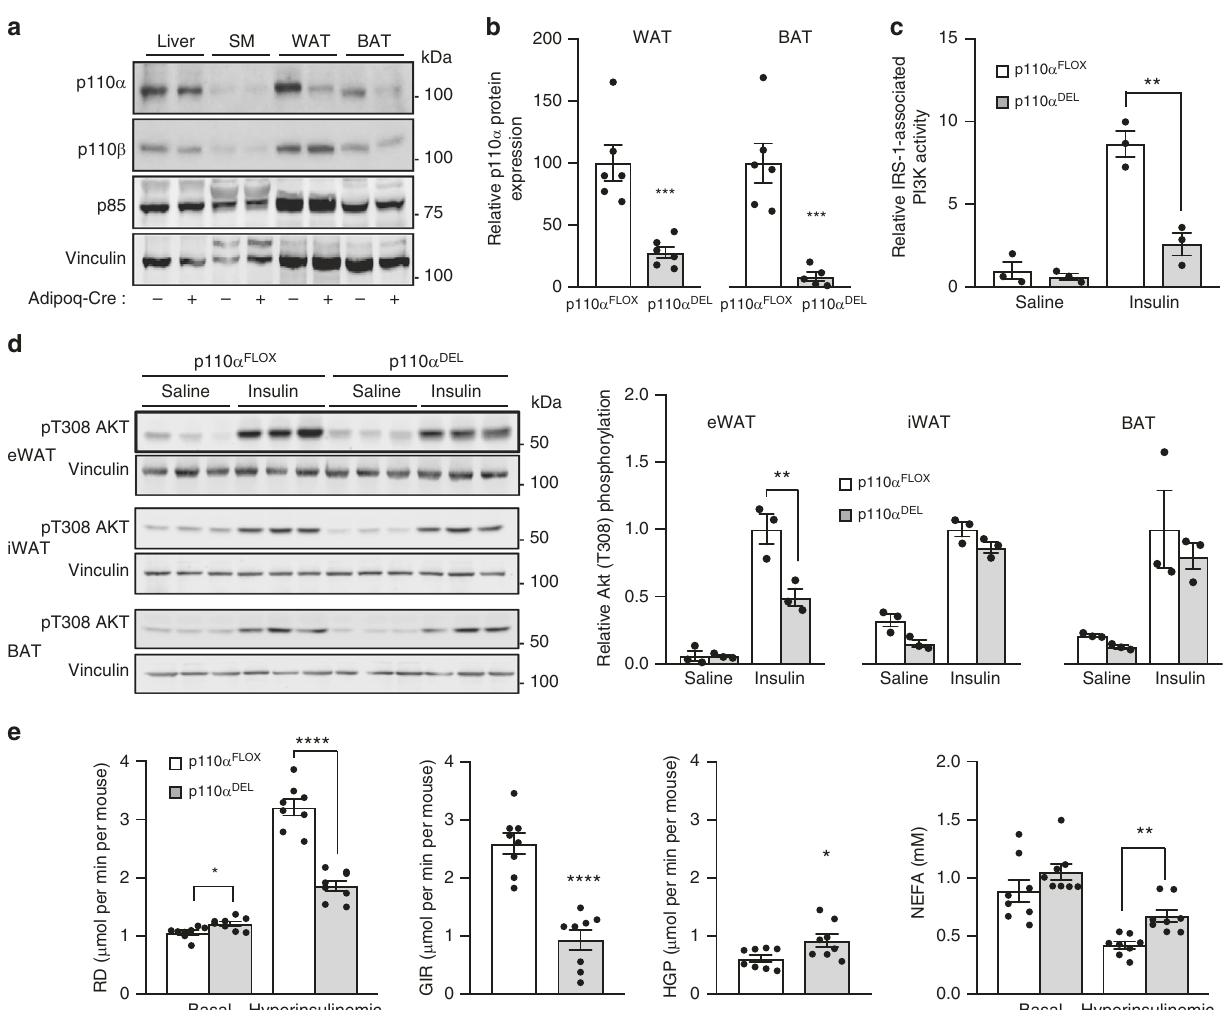
Fig. 1 Adipose tissue-speci fi c p110 α DEL mice are insulin resistant. a Representative immunoblot analysis of p110 α protein levels in homogenates of metabolic tissues isolated from approximately 1.5-year-old male mice carrying or not the Adipoq – Cre transgene. Blots were also probed for the widely expressed p110 β isoform and the PI3K regulatory subunit p85. Vinculin was probed as loading control. SM skeletal muscle (gastrocnemius), WAT white adipose tissue (epididymal), BAT brown adipose tissue (interscapular). b Semi-quantitative data for p110 α expression in WAT and BAT ( n = 6 mice per genotype). The respective blots are shown in Supplementary Fig. 1. c , d One-year-old mice ( n = 3 per genotype) were injected intraperitoneally with 100 mU g − 1 of insulin. After 30 min, tissues were excised and snap frozen. c Adipose tissue (epididymal) lysates were immunoprecipitated with IRS-1 antibodies and assayed for associated PI3K lipid kinase activity. d Immunoblot analysis of adipose tissue (epididymal, eWAT; inguinal, iWAT; interscapular brown, BAT) lysates probed for Akt T308 phosphorylation. Each lane represents an individual mouse. e Hyperinsulinemic – euglycemic clamp analysis